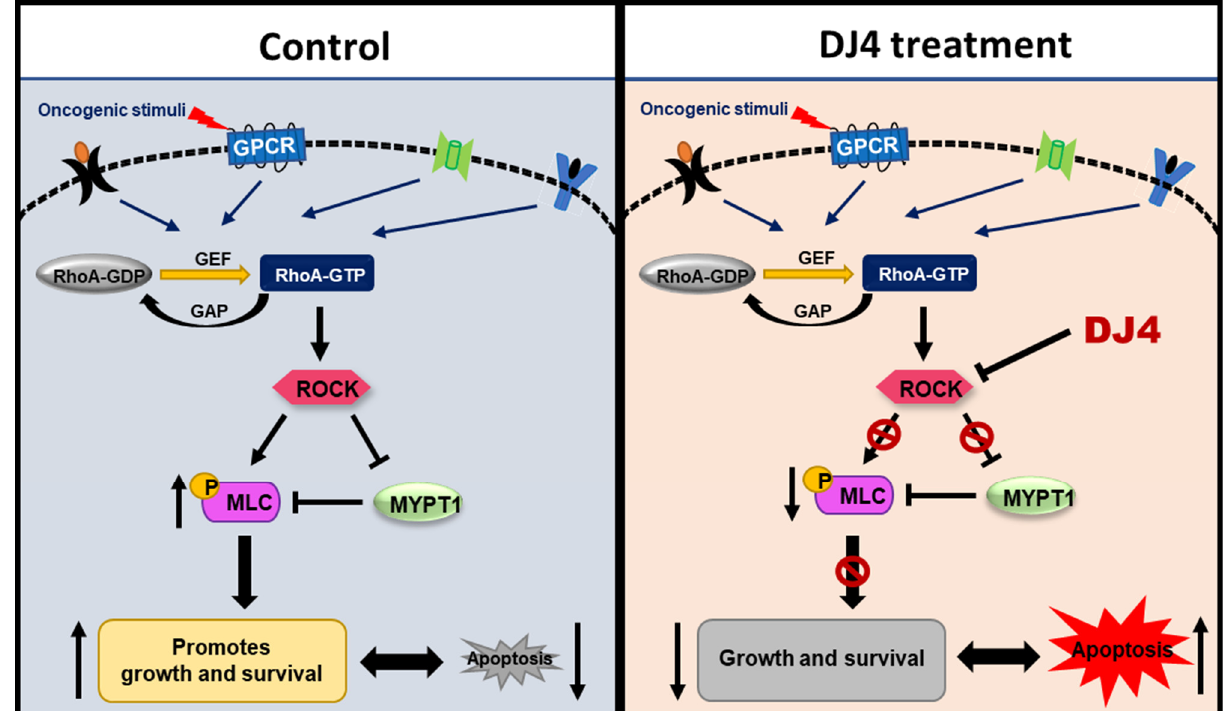
Figure 8. ROCK inhibitors such as DJ4 may reduce the phosphorylation of downstream targets such as MLC2 and MYPT1. Blocking ROCK-related pathways can potentially have therapeutic benefits by restoring proliferation and apoptotic cascades that may be improperly signaling due to malignant transformations arising from cancer.